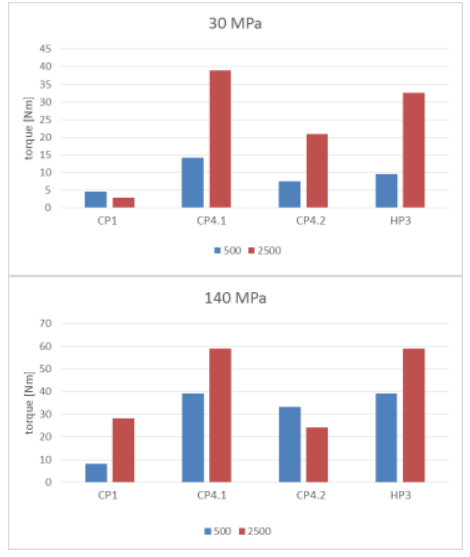
Fig. 3. Torque amplitude on the pump shaft at a pumping pressure of 30 and 140 MPa and pump shaft speeds of 500 and 2500 rpm Figure 10 and Fig. 11 show the minimum and maximum torque values in relation to the pumping pressure and the pump shaft speed. The most regular torque, mostly of posi- tive or slightly negative (approx. –3 and –7 Nm) values, over the entire operating range is for the CP1 and CP4.2 pumps. The second group is the CP4.1 and HP3 pumps. The torque takes both positive and negative values. The CP4.1 pump has higher negative values of approx. –25 Nm